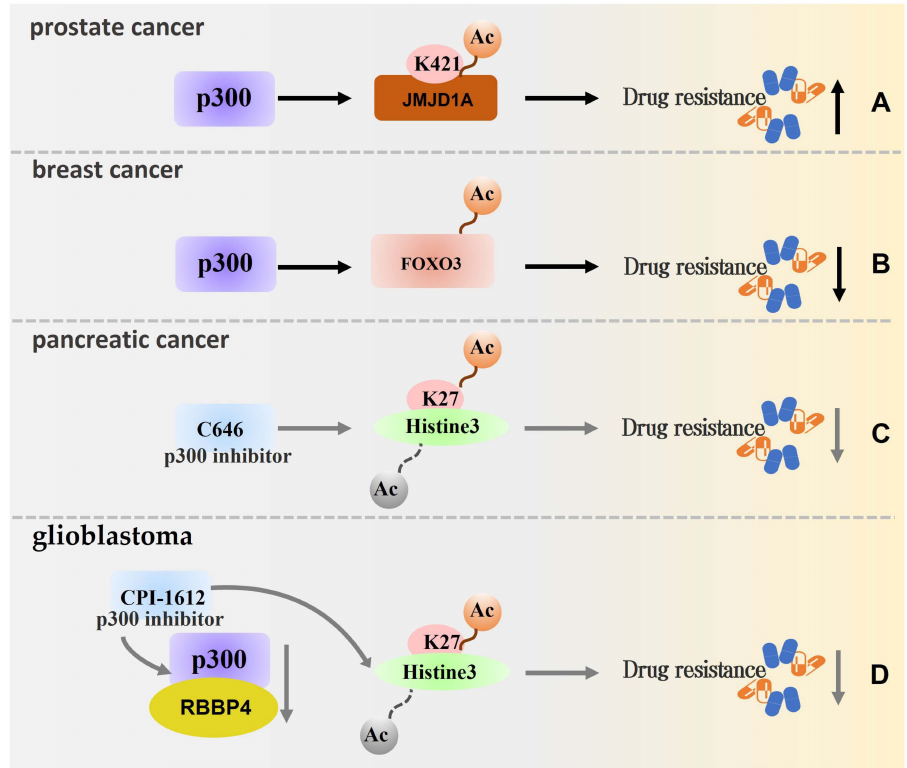
Figure 5. Schematic of the modulation of resistance by p300. ( A ) p300 promoted the acetylation of JMJD1A k421, and the acetylation level of JMJD1A increased in drug-resistant prostate cancer cell lines. ( B ) p300 mediates the acetylation of FOXO3 and enhances the sensitivity to lapatinib in the treatment of breast cancer. ( C ) C646 inhibits the acetylation of H3K27 to a degree that inhibits gemcitabine resistance in the treatment of pancreatic cancer. ( D ) After treatment with p300 inhibitor CPI-1612, the activity of RBBP4/p300 HAT was effectively blocked, which made the treatment of glioblastoma sensitised to temozolomide (TMZ). (Remarks: The grey arrow is the related process in which p300 inhibitors participate in regulation, and the dotted line is the process in which modification types are